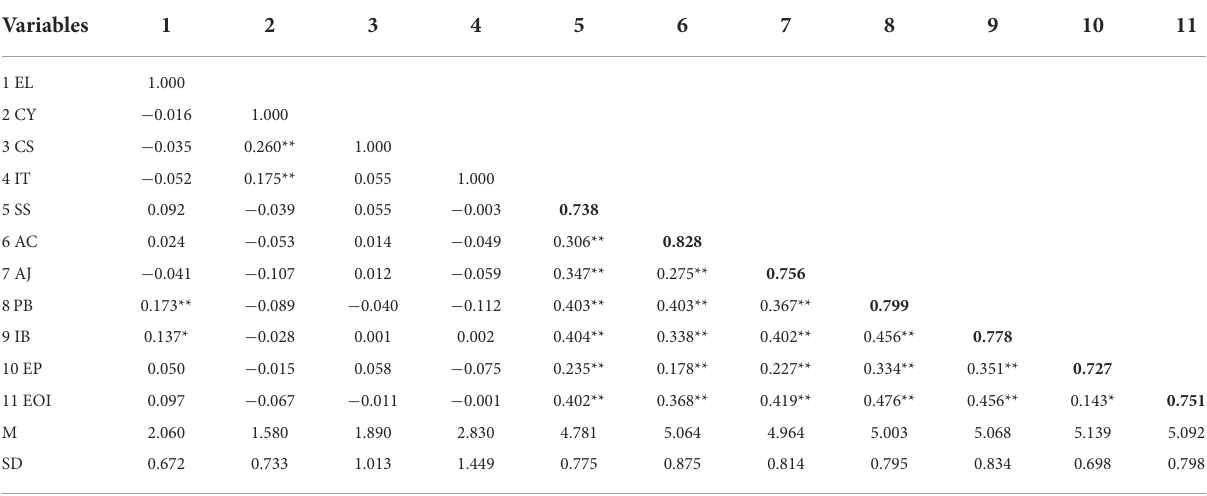
TABLE 3 Mean, standard deviation, correlation coefficient, and AVE square root values of each variable.